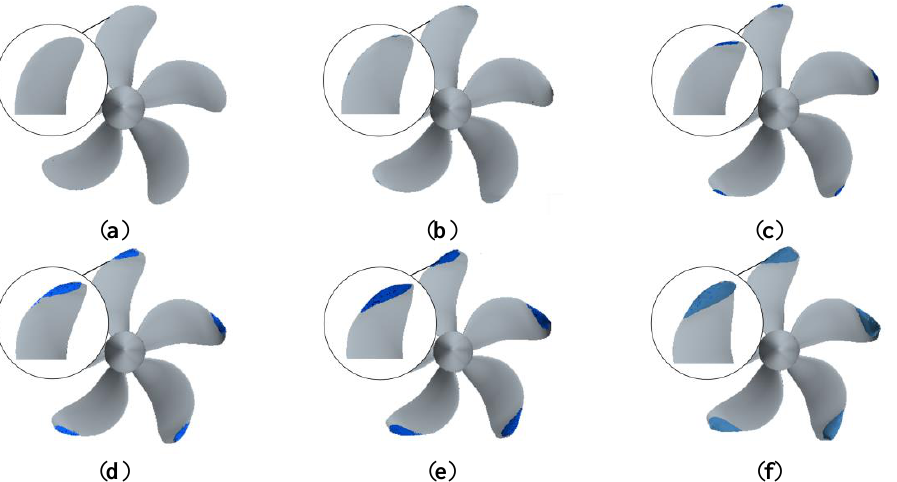
Figure 18. The sheet cavitation distributions of propeller Kap00 ( a ), Kap01 ( b ), Kap02 ( c ), Kap03 ( d ), Kap04 ( e ) and Kap05 ( f ) (J = 0.5, 30 rps, and σ = 2.0).